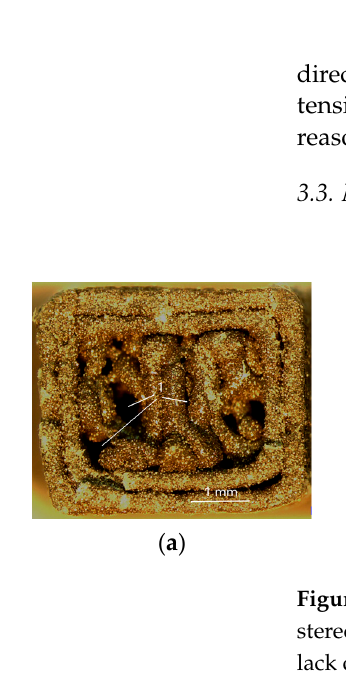
( c ) Figure 7. Cross-section of specimen 1.0 2Z composed of PLA + bronze after fracture observed with a scanning electron microscope. Observation direction—perpendicular to the cross-section; ( a ) mag- nification ×25; ( b ) magnification ×100; ( c ) magnification ×200. ( a ) ( c ) Figure 8. Cross-section of specimen 1.0 2Z composed of PLA + bronze after fracture observed with a scanning electron microscope. Observation direction—at an angle of 45° to the cross-section; ( a ) magnification ×25; ( b ) magnification ×100; ( c ) magnification ×200.